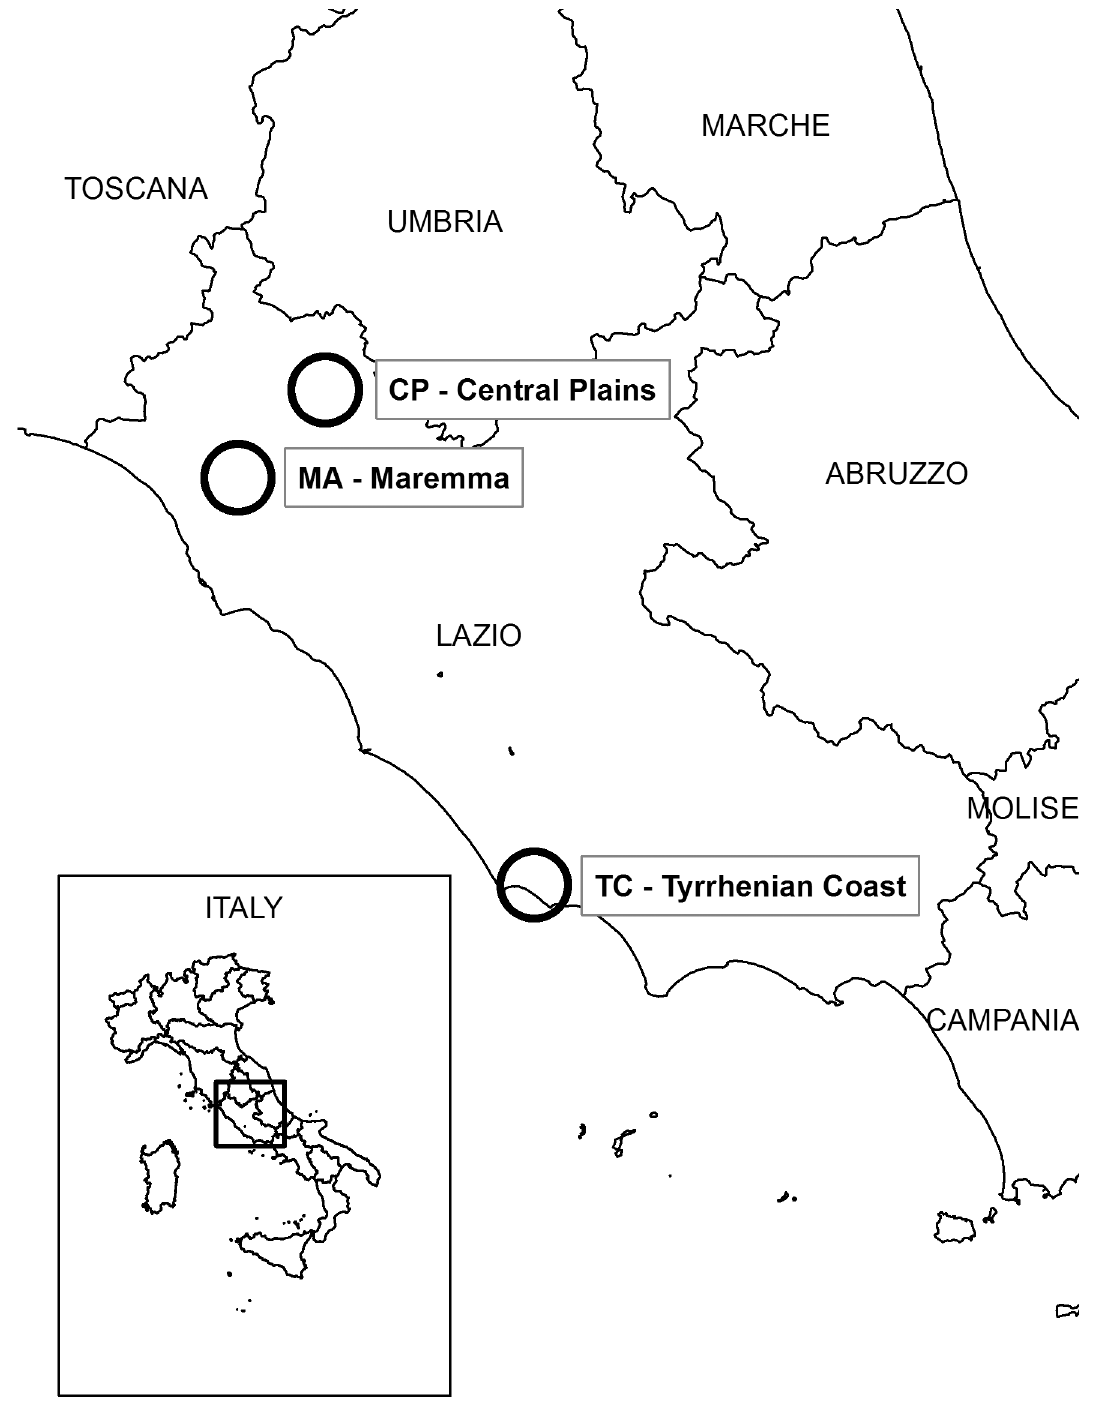
Fig 1. Sampling areas(TC: Tyrrhenian Coast, MA: Maremma, CP: Central plains).